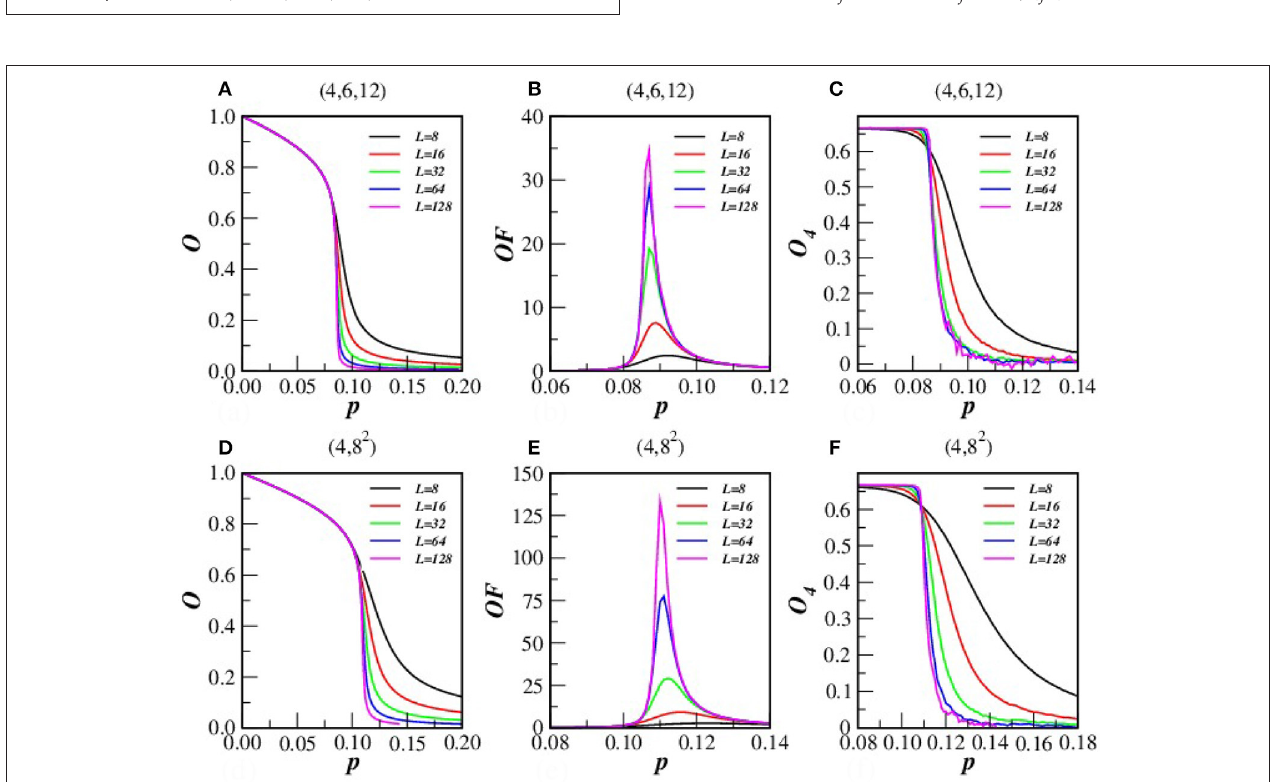
FIGURE 2 | (Color on-line) O , OF , and O 4 vs. p , for sizes L = 2 3 ,2 4 ,2 5 ,2 6 and 2 7 and N = 12 L 2 (for 4, 6, 12) AL (first line) and N = 4 L 2 sites for (4, 8 2 ) AL (second